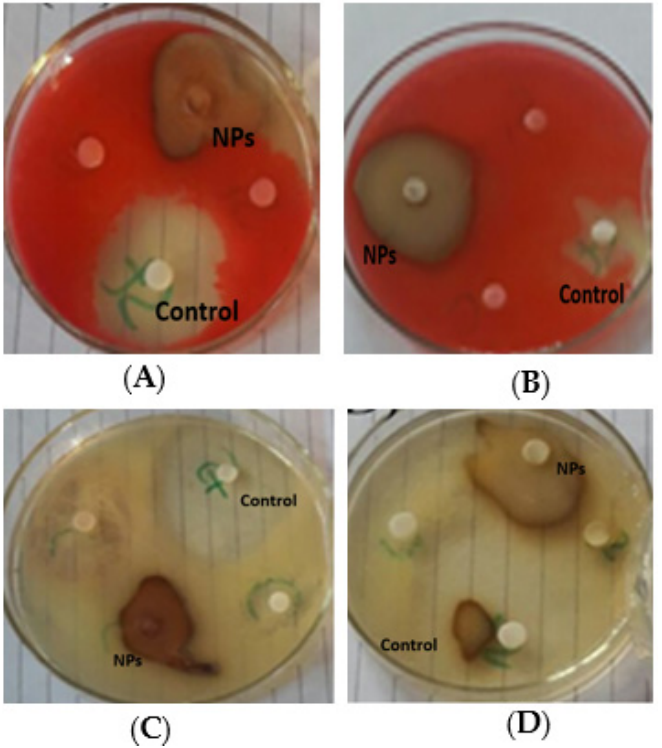
Figure 8. Antibacterial activity of leaf- and bulb-capped AgNPs and plant (leaf and bulb) extract against Staphylococcus aureus ( A ) and ( B ) and Pseudomonas aureginosa ( C ) and ( D ).